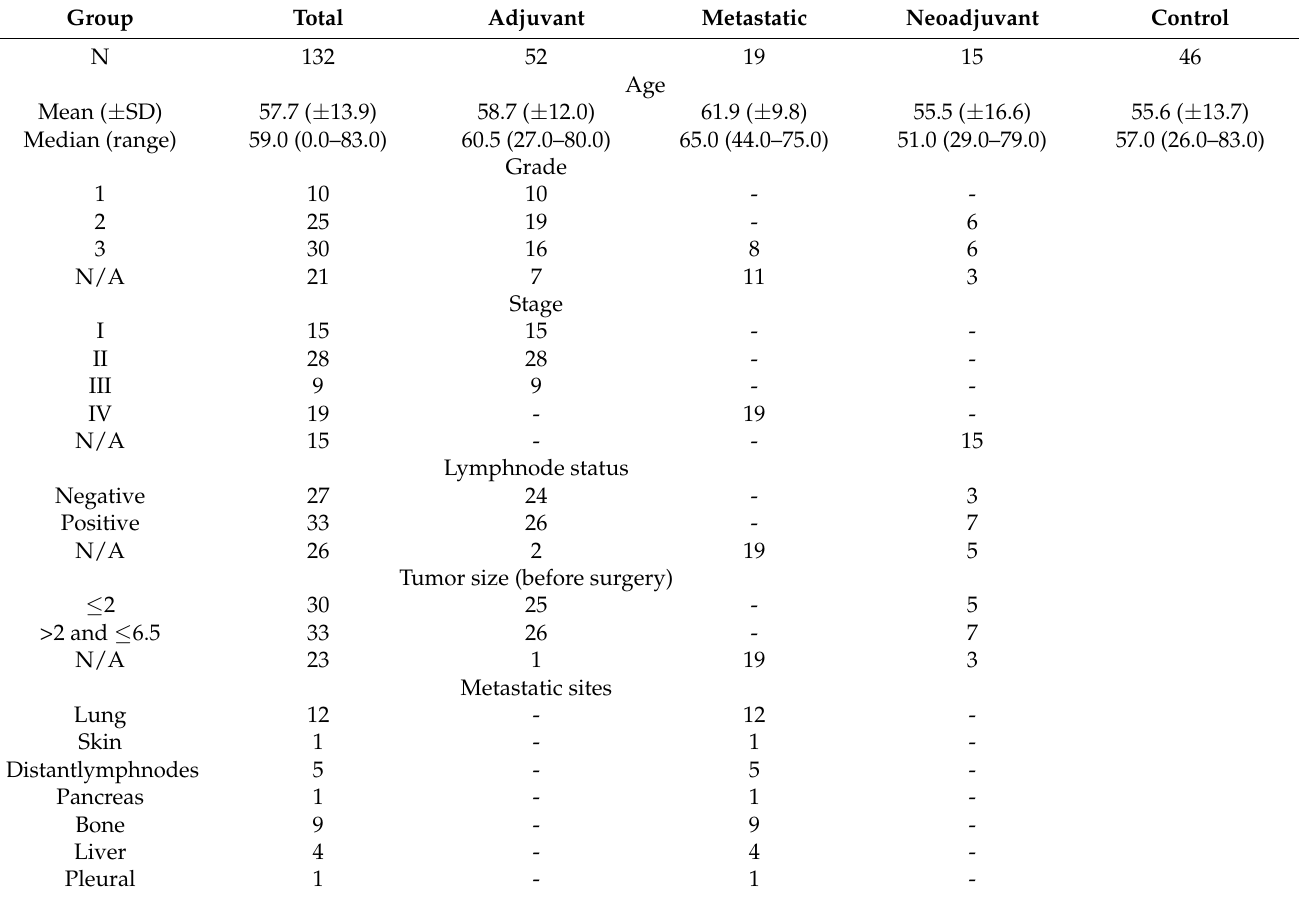
Table 7. Demographic and clinicopathological characteristics of BrCa and control